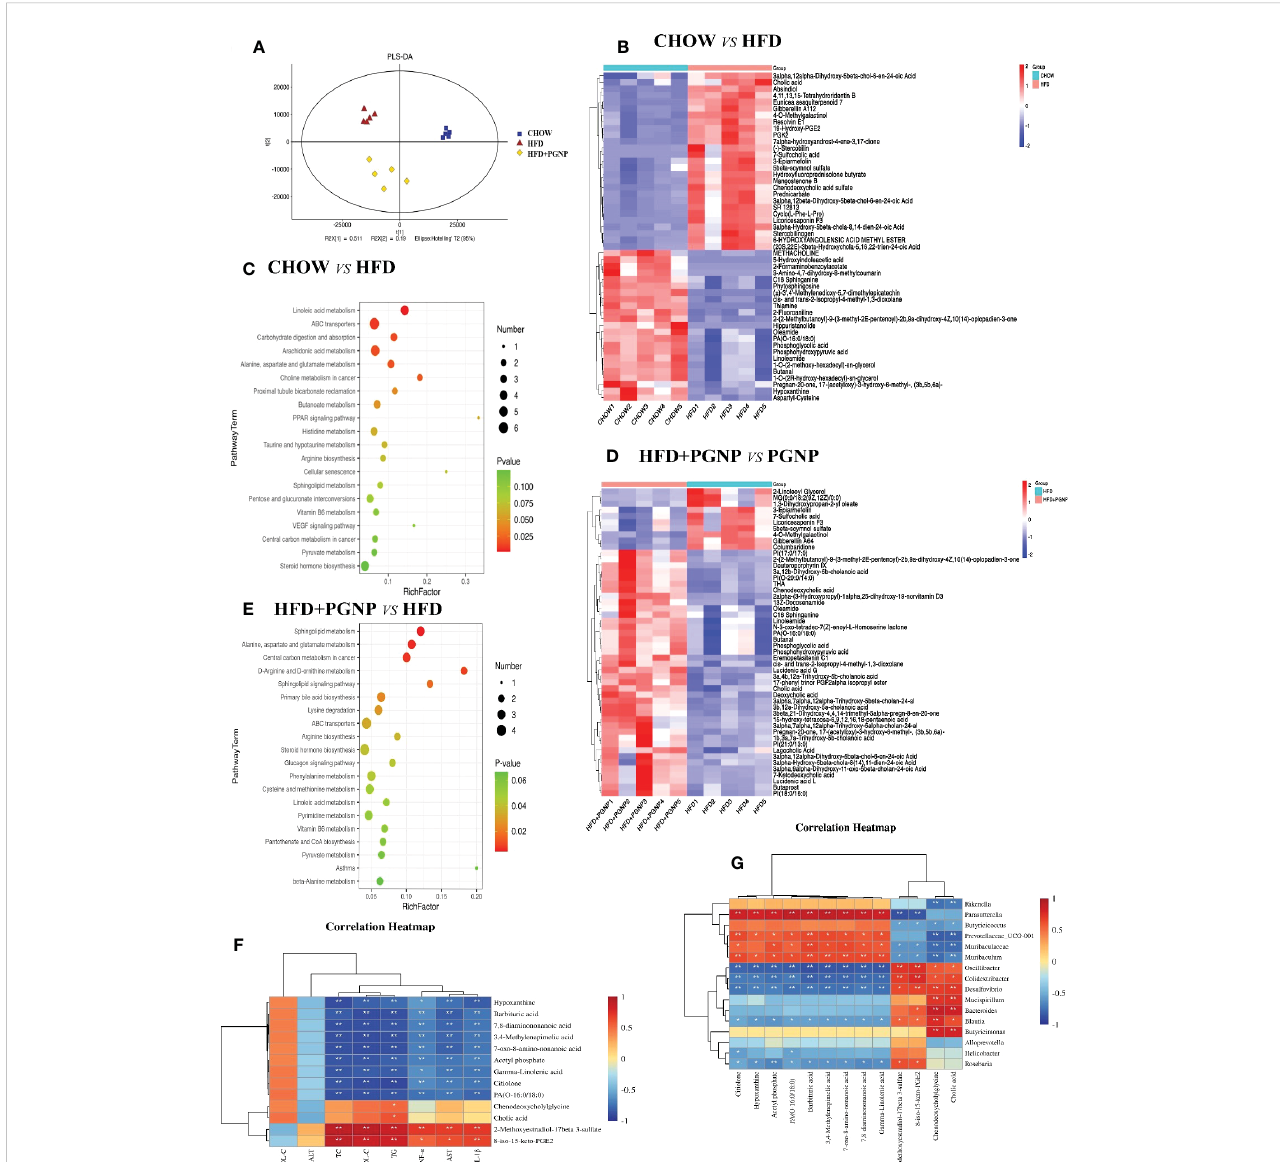
FIGURE 6 Alterations of the metabolite levels in samples after HFD or HFD + PGNP treatment. PLS-DA of metabolites in the CHOW, HFD, and HFD+PGNP groups (A) . Heatmap of the altered metabolites in CHOW and HFD (B) . KEGG enriched pathways of the altered metabolites in CHOW and HFD (C) . Heatmap of the altered metabolites in HFD+PGNP and HFD (D) . KEGG enriched pathways of the altered metabolites in HFD+PGNP and HFD (E) . Correlation of metabolites and gut microbiota (F) . Correlation of metabolites and pharmacodynamic parameters (G) . * P < 0.05; ** P <